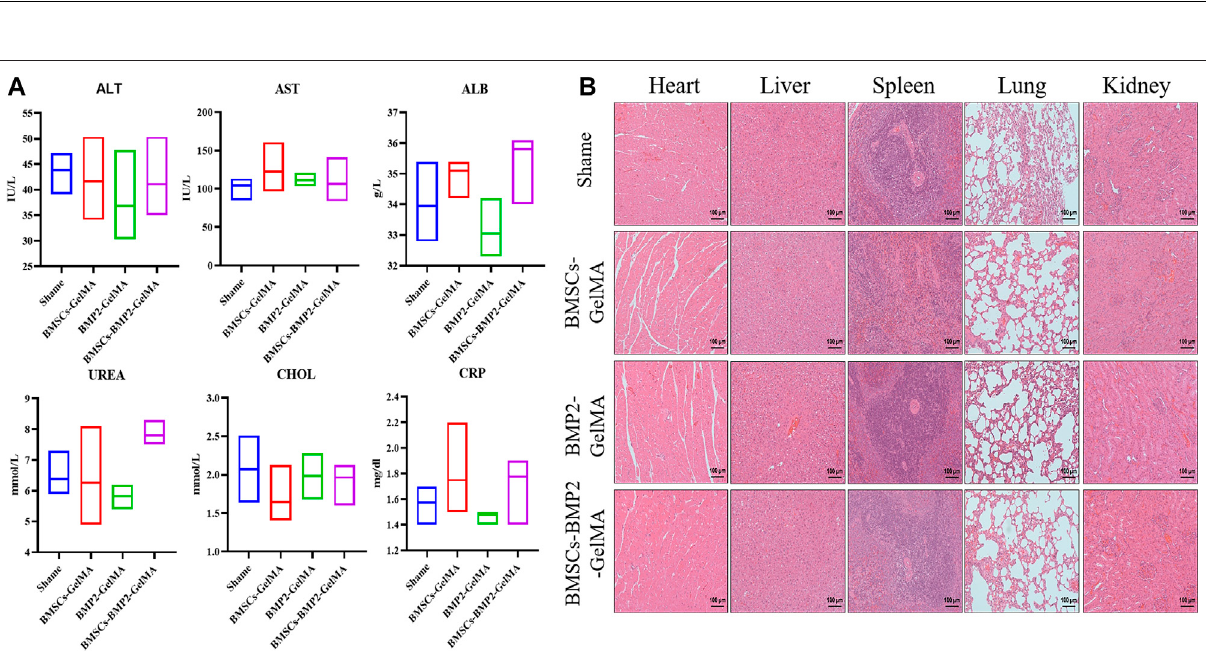
Frontiers in Bioengineering and Biotechnology |